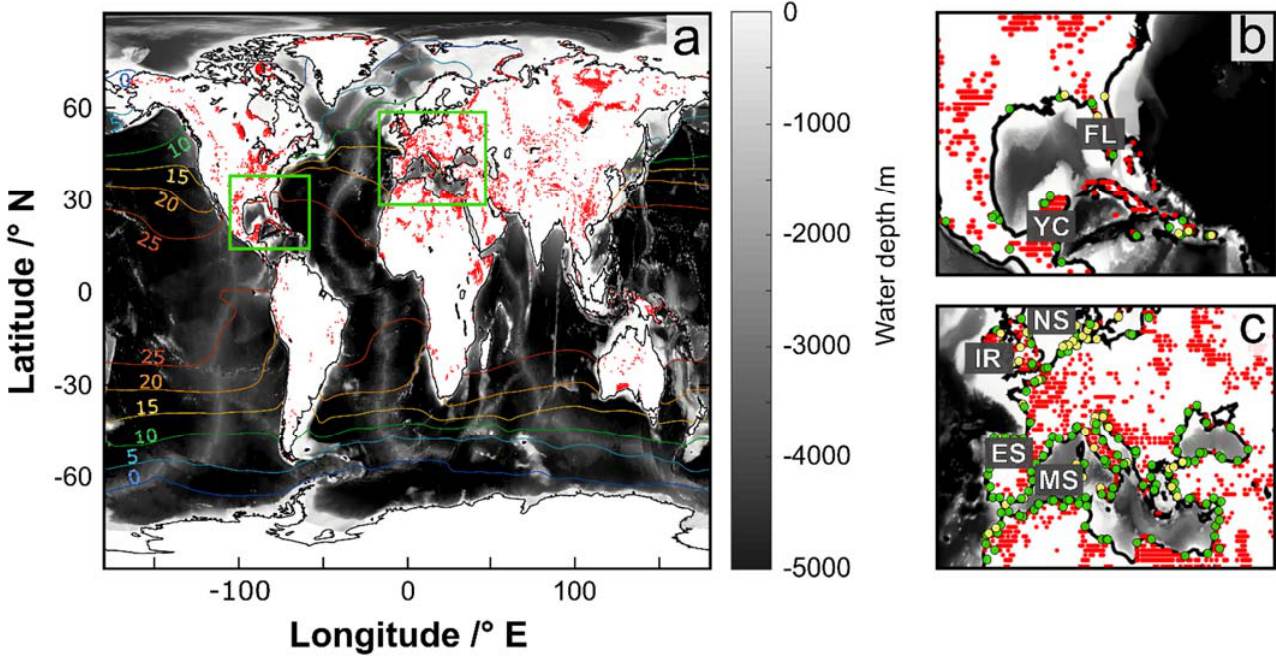
Figure 3. Identification of appropriate locations for AWL. ( a ) Overview of limestone occurrence, water depth and SST. Red: limestone occurrence based on the GLiM database [42]. Bathymetry data on a one-minute grid are from GEBCO [43]. Mean annual sea surface temperatures are from the NOAA Extended Reconstructed SST version 4 [44]. The areas in the green rectangles in ( a ) are enlarged in ( b , c ), respectively. Yellow dots: coal-fired power plants according to the Global Coal Plant Tracker [40]. Green dots: a single or several nearby cement plants where limestone waste occurs; according to CemNet [45] IR: Ireland, ES: Spain, NS: North Sea, MS: Mediterranean Sea, FL: Florida, YC: Yucat á